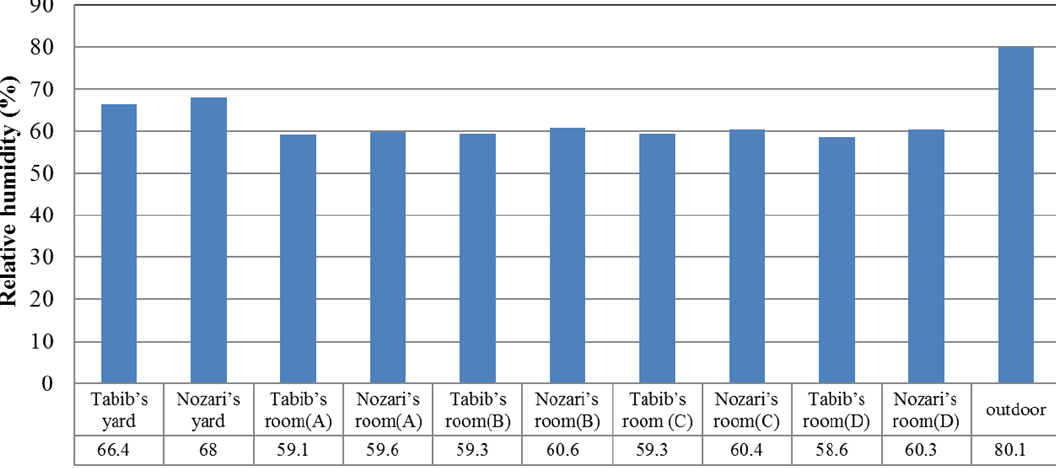
Figure 17. Average relative humidity of spaces during test days (August 30 and, September 1, 4, 16, 23, 27, and 30, 2016).